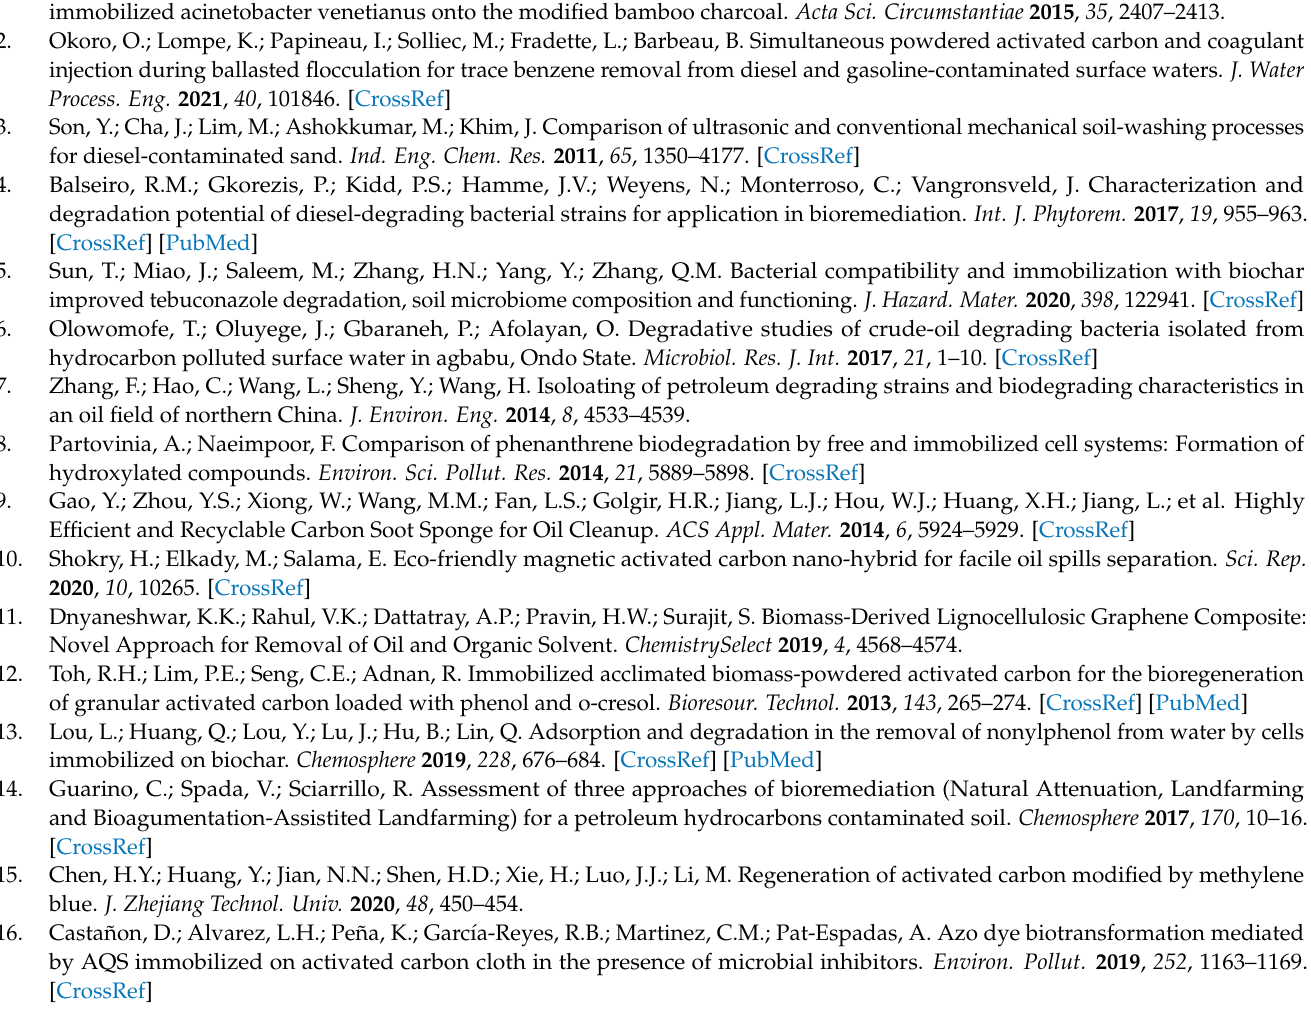
Figure S2: Changes in the Shannon–Wiener index values of bacteria after immobilization on